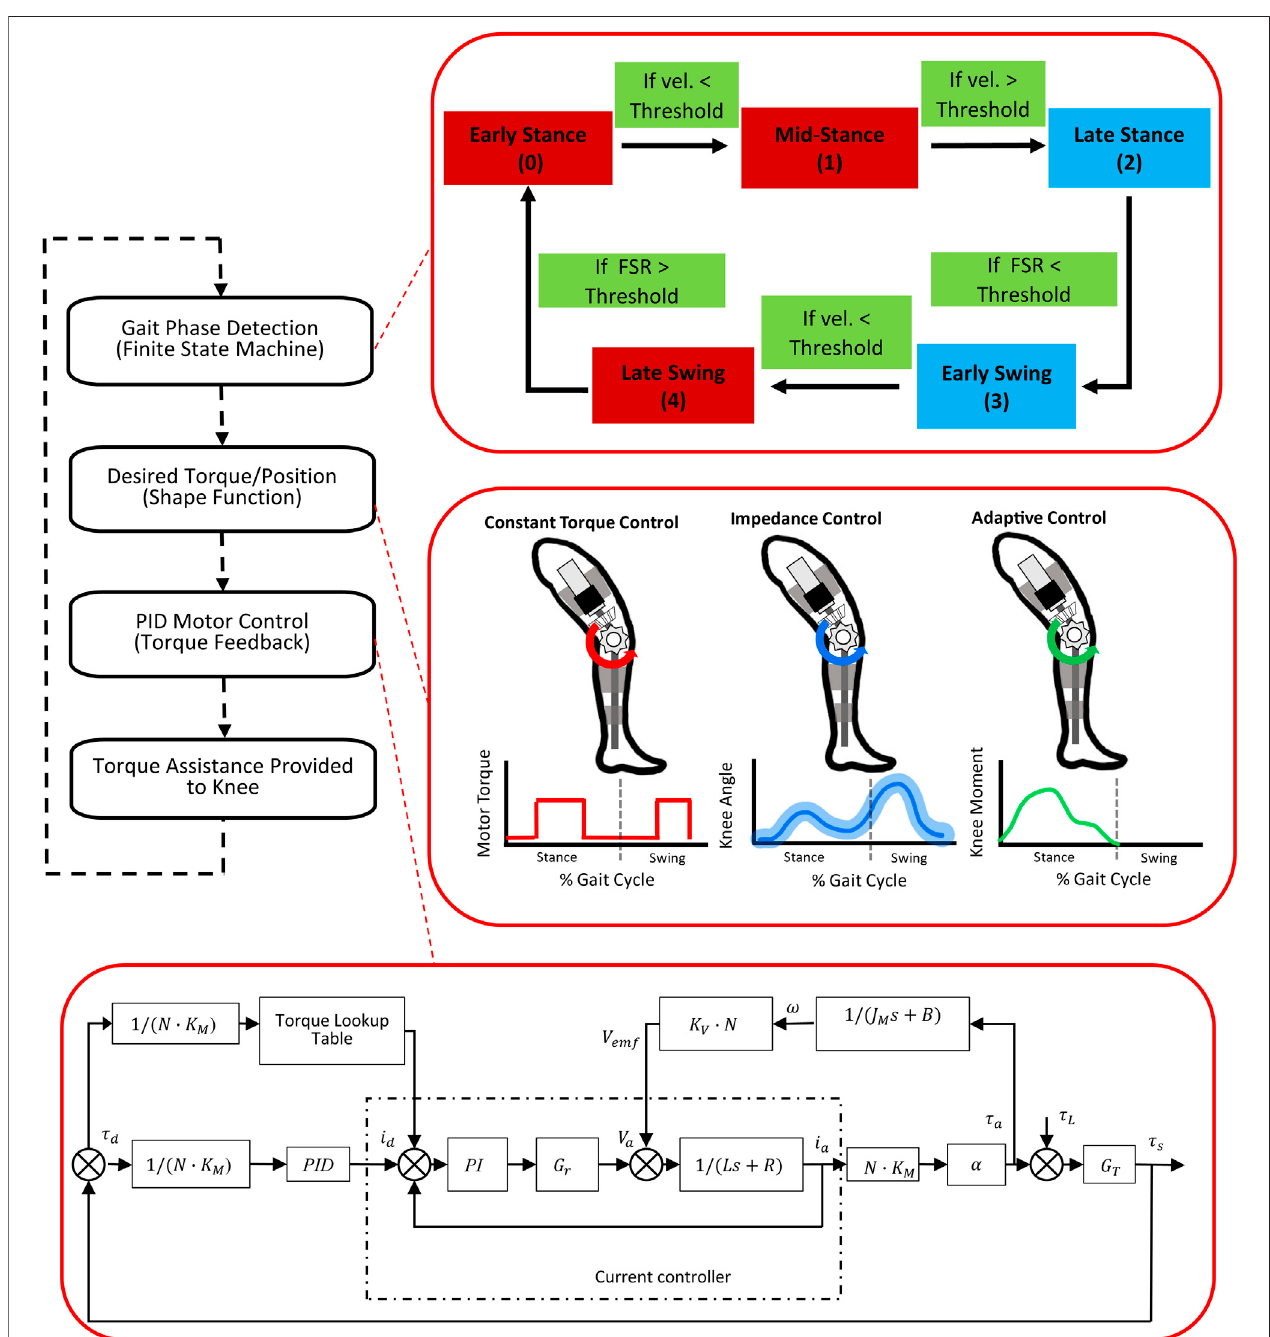
FIGURE 2 | The hierarchical real-time control loop running on the embedded microcontroller during exoskeleton operation. The diagram on the top right inset shows the 5 state fi nite state machine. Red blocks are states where extension assistance was provided. The middle right inset shows the three different assistance modes of the P.REX. The diagram in the bottom right inset shows the feed-forward and feedback closed loop control for torque delivery within the selected mode.